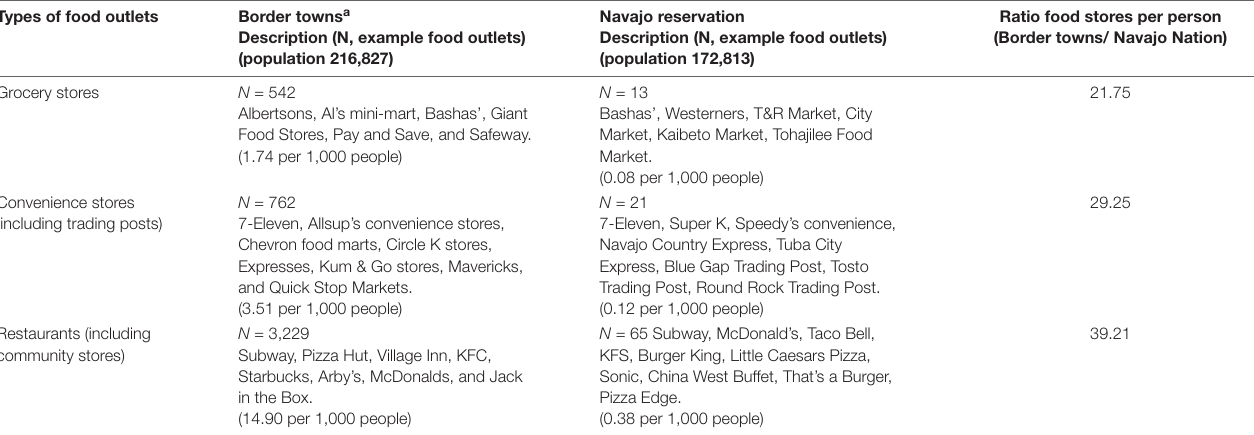
TABLE 2 | Description of types of food